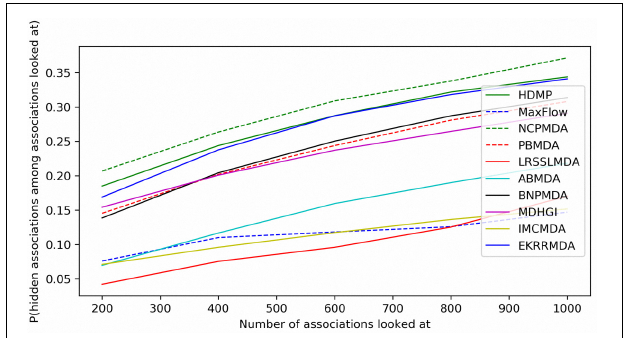
FIGURE 4 | Performance comparisons between EKRRMDA and other prediction models in terms of CDF of ranks based on global